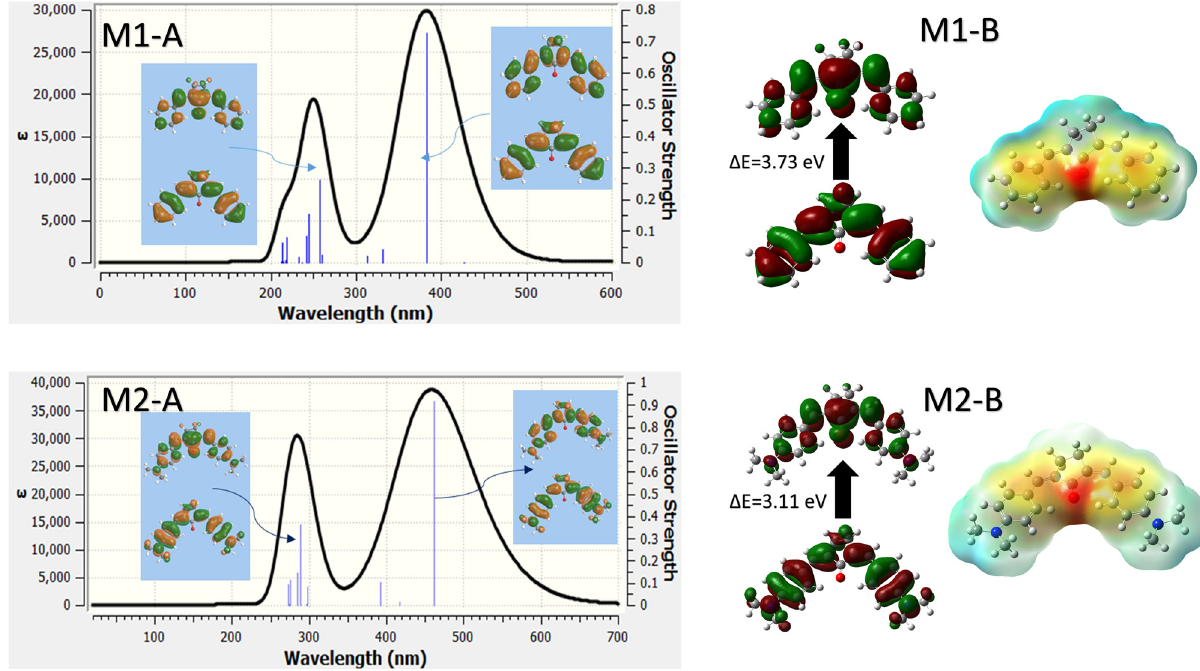
Figure 3: Calculated UV - Vis spectra of M1 ( top left ) and M2 ( bottom left ) in acetonitrile. Frontier molecular orbitals relevant for the electronic transition and the corresponding energy di ff erences – M1 ( top right ) and M2 ( bottom right ) .